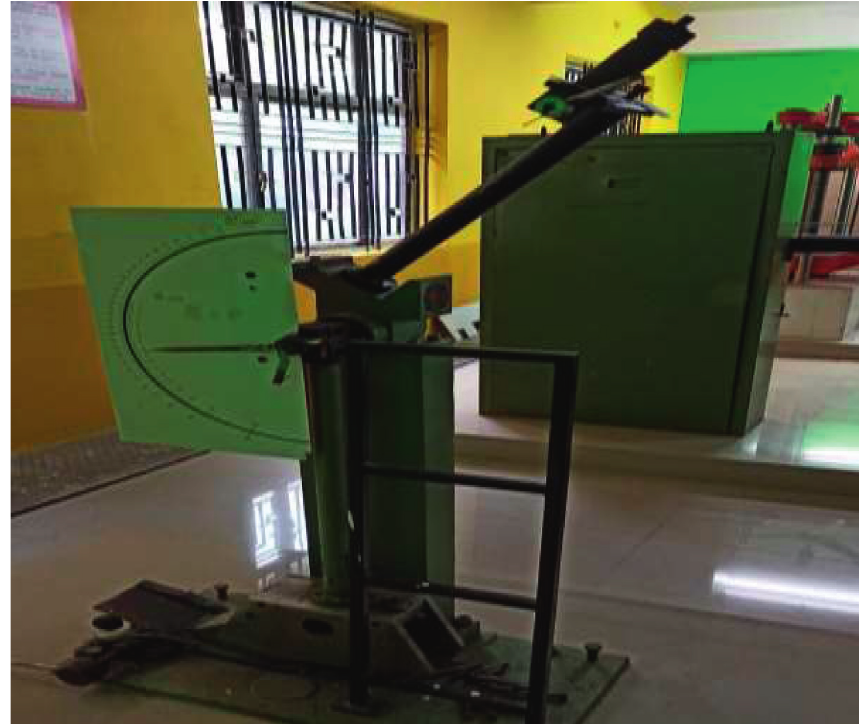
Figure 8: Impact Testing